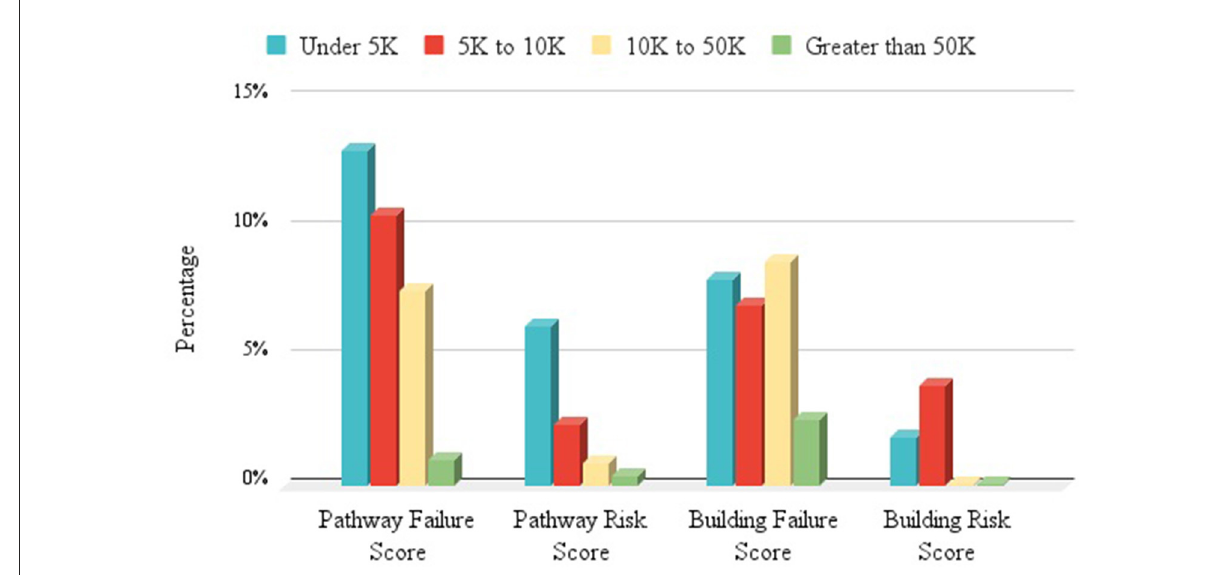
FIGURE6 Failure and Risk Scores by Community Population Groups—shows pathway and building failure and risk scores by community groups ranging from under 5,000 to over 50,000 people. Failure and Risk Scores reflect the percentage of features that were scored a zero (failure) and the percentages scored a one (risk) of the total number of features scored. The Building Risk Scores for the two more populous groups of communities were <